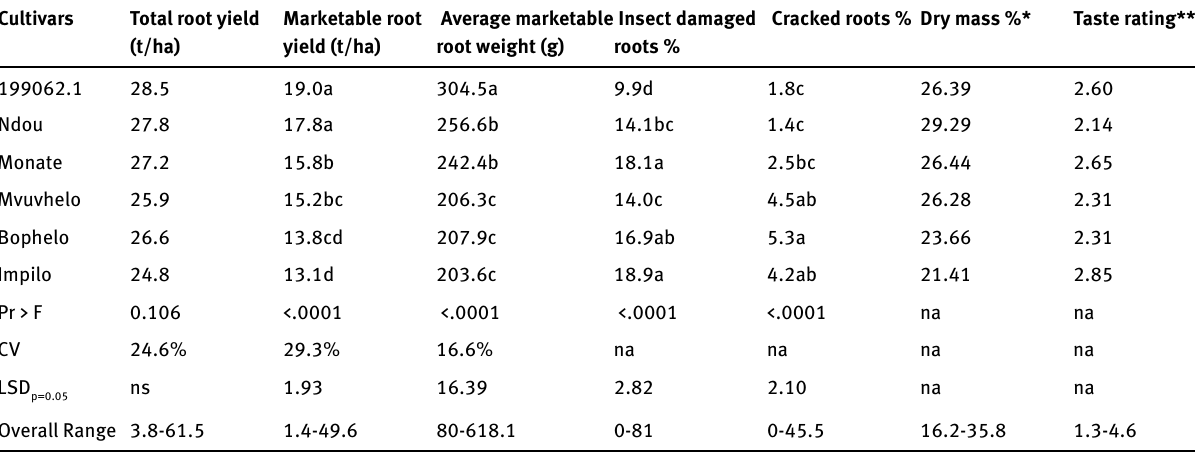
Table 4: Mean storage root yield performance for six cultivars over 15 on-farm sites in South Africa